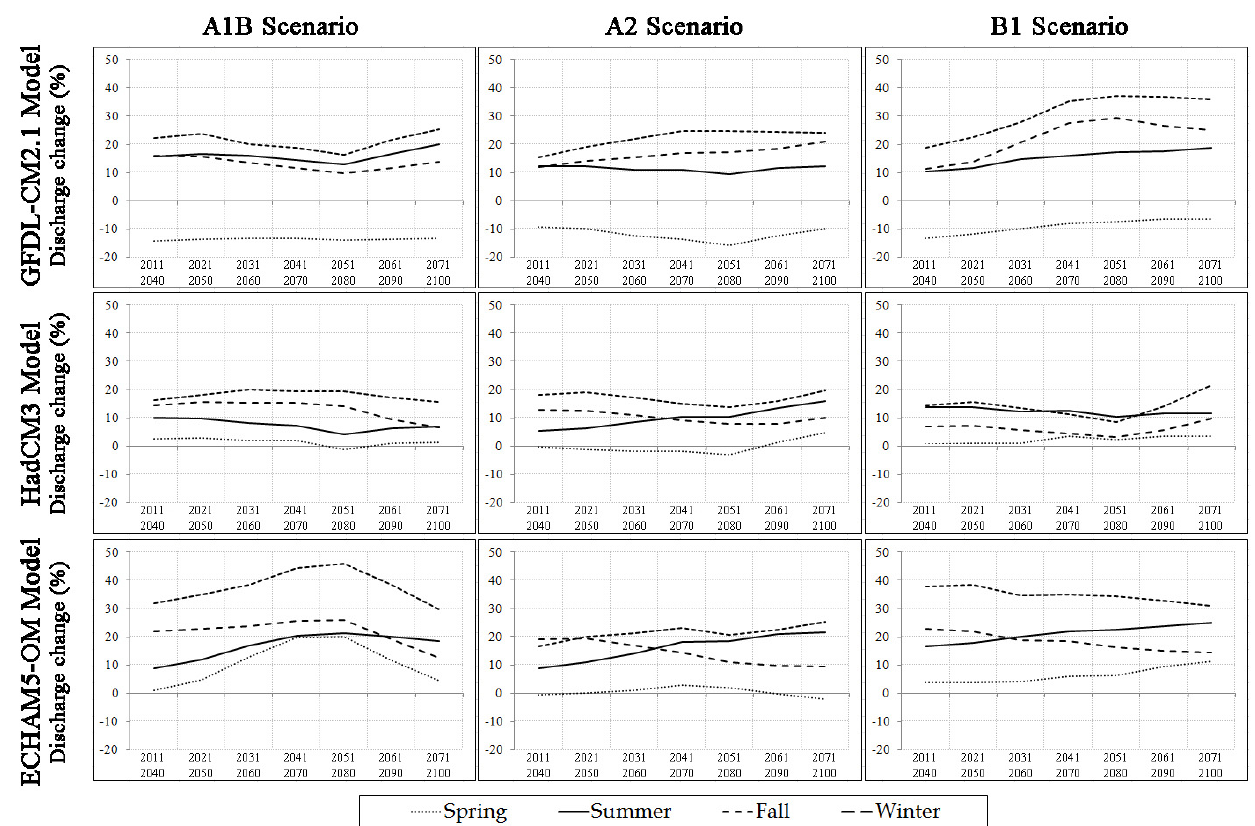
Figure 9. Projected change in total seasonal discharge in the rest of the twenty-first century produced by different GCMs in different IPCC-SRES